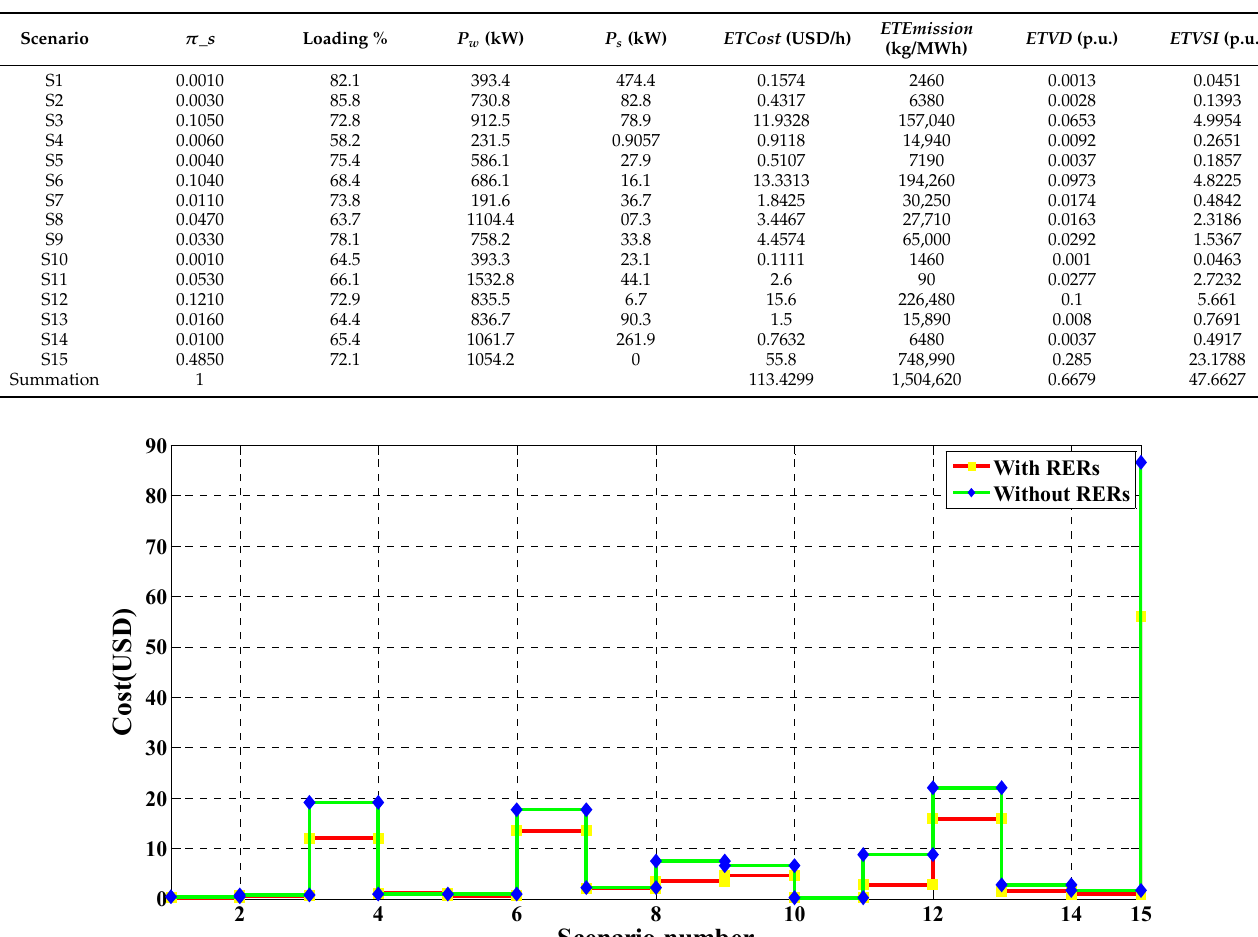
Table 8. The 51-bus system simulation results.